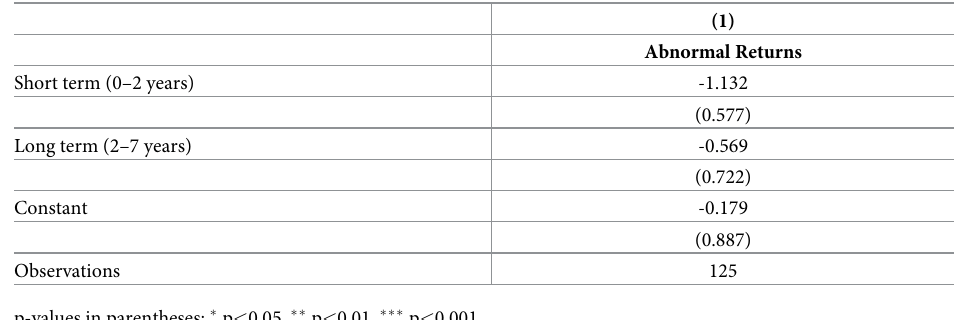
Table 4. BP abnormal returns pre vs post disaster.